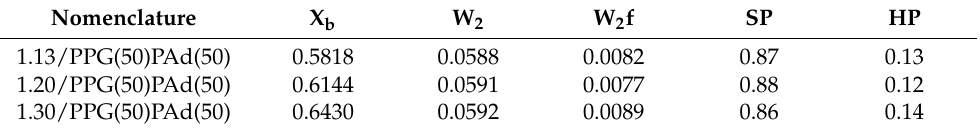
Table 10. Main parameters for determining the micro-mixing of the hard and soft phases in the